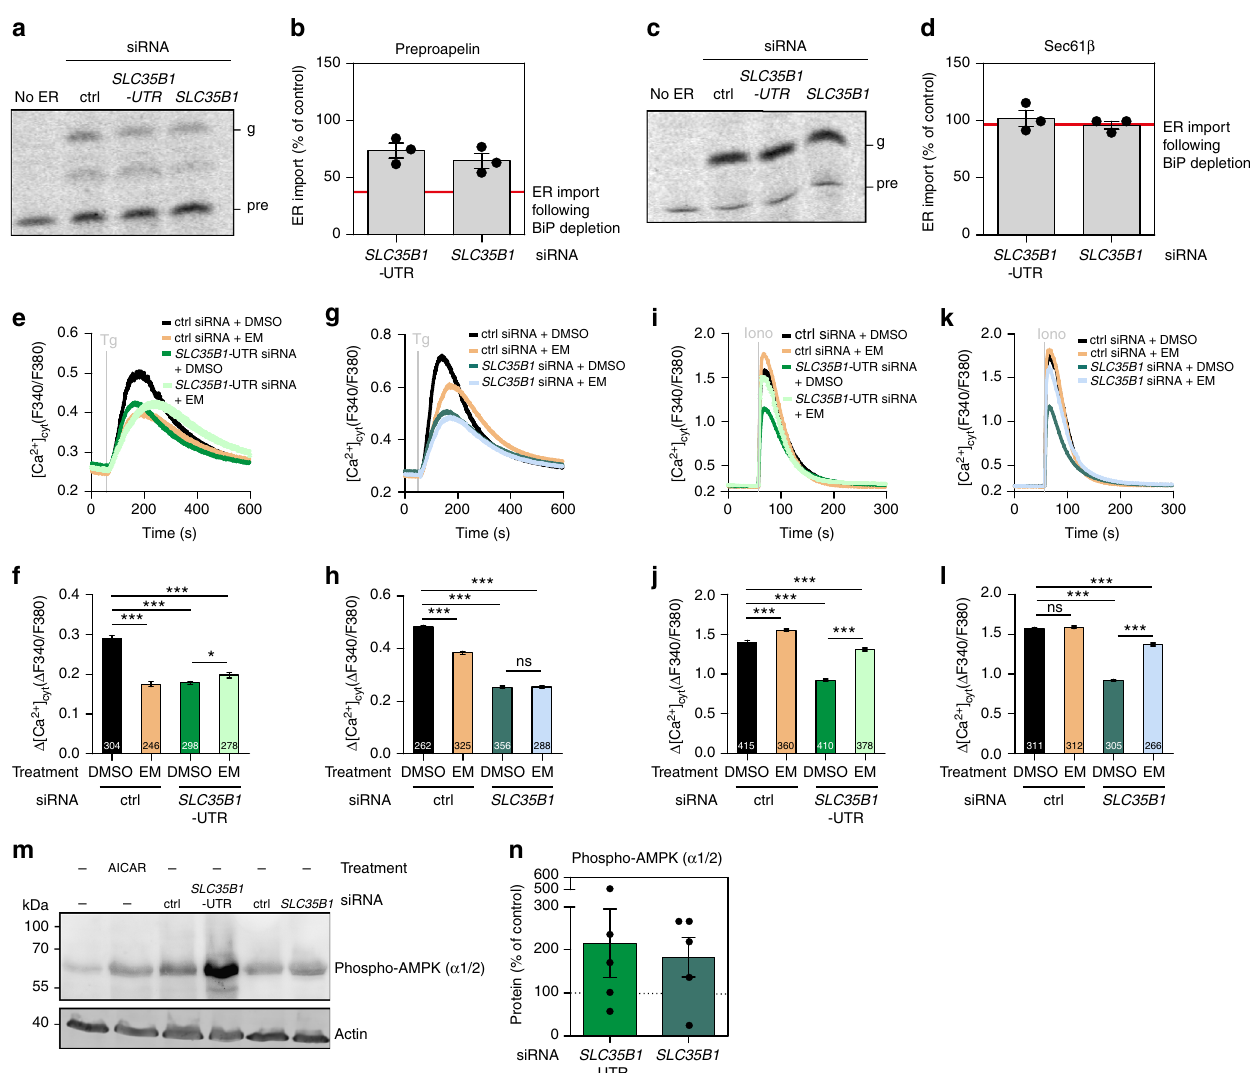
Fig. 8 Knockdown of SLC35B1 leads to inhibition of BiP activity and to AMPK phosphorylation. a – d HeLa cells were transfected with control siRNA or with SLC35B1 -targeting or SLC35B1 -UTR-targeting siRNA for 96 h. They were converted to semi-permeabilized cells and tested for protein transport activity as described previously 6,26,38,39 . Here, ER protein import, assayed as N-glycosylation, of the small presecretory protein preproapelin 26 (which depends on BiP, ( a , b ), and of the tail anchored Sec61ß 26 (which does not depend on BiP, ( c , d ) were analyzed. The effects of siRNA-mediated depletion of BiP are shown for comparison 26 . Representative phosphorimages after SDS-PAGE and quantitative data from three independent experiments are reported together with the individual data points as % of control with SEM. Pre, precursor form; g, glycosylated form. e – l HeLa cells were transfected with control siRNA or with SLC35B1 - or SLC35B1 -UTR-targeting siRNA for 96 h. Where indicated, 0.0001% DMSO, or 10 µ M emetine (EM) were present during the last 2 h of growth plus Fura loading. Cells were loaded with Fura-2 for 30 min, transferred to Ca 2 + -free buffer, and Fura-2 signals were recorded as F 340 /F 380 ratios in real- time 6,27 . Where indicated, 1 µ M Thapsigargin (Tg), or 5 µ M Ionomycin (Iono) were added. e , g , i , k The mean values of the ratiometric recordings are shown with the standard error of the mean (SEM). f , h , j , l Statistical analysis of Tg-induced ( f – h ) or Iono-induced ( j – l ) changes in cytosolic Ca 2 + levels in the experiments with the indicated number of cells in at least three independent experiments. The indicated pairs were assessed by unpaired, two-sided Student´s t -test (* P < 0.05, ** P < 0.01, ** P < 0.001, ns, not signi fi cant). m , n Where indicated, 0.5 mM AICAR was present for 15 h. Cells were treated as indicated and analyzed by SDS-PAGE and Western blotting using phosphorylated AMPK-speci fi c antibodies. Notably, AICAR is an AMP-mimetic and AMPK activator 46 . Staining the blot for ß-actin served as a loading control. Representative luminescence images of the blots and quantitative data from fi ve independent experiments are reported together with the individual data points as % of control with SEM the FUSION-CAP software 16.11 (PEQLAB). A home-made and af fi nity puri fi ed used dilution: 1:200) were obtained from Sigma, antibodies against tGFP (AB514, rabbit antipeptide antibody directed against the COOH terminal undecapeptide of rabbit polyclonal, used dilution 1:2,500) were from Evrogen, and antibodies against human Sec62 protein (plus an aminoterminal cysteine) and Alexa Fluor594- phosphorylated AMPK alpha 1 and 2 (ab133448, rabbit monoclonal, used dilution: coupled secondary antibody from goat (Invitrogen A-11012, goat polyclonal, used 1:1,000) were from ABCAM. Primary antibodies (ß-actin, Myc-DDK) were dilution: 1:1,000) was used for fl uorescence microscopy. The ApoSENSOR Biolu- visualized with ECL TM Plex goat anti-mouse IgG-Cy3 conjugate (Sigma C2181, minescent Assay Kit was from BioVision and was used according to the manu- used dilution: 1:2,500) using the Typhoon-Trio imaging system combined and facturer´s instructions within an in fi nite M200 plate reader (TECAN). AICAR Image Quant TL software 7.0 (GE Healthcare). Alternatively, they were visualized (5-aminoimidazole-4-carboxamide-1-ß-D-ribofuranoside), and emetine were from with peroxidase-coupled secondary antibodies (Sigma A8275, used dilution: Sigma. We note that the full scans of blots and radioactive gels are shown in 1:1,000), Super Signal West Pico (Pierce) (phosphorylated AMPK) or Super Signal Supplementary Figs. 9 – 14. West Femto (Pierce) (SLC35B1), and luminescence imaging using Fusion SL with NATURE COMMUNICATIONS| (2018) 9:3489 |DOI: